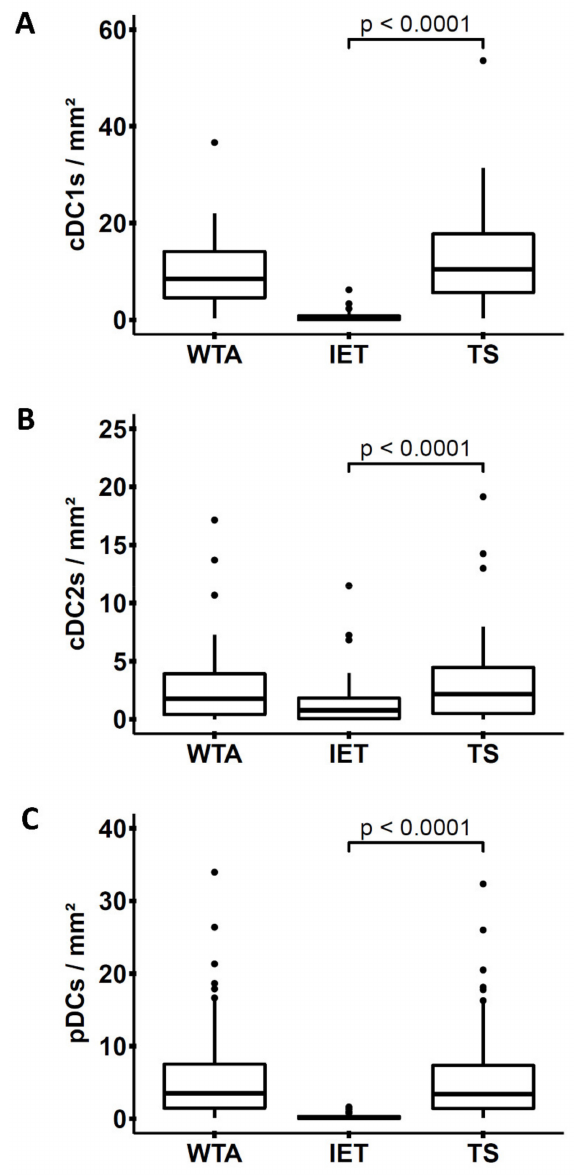
Figure 2. Frequency of pancreatic ductal adenocarcinoma (PDAC)-associated conventional dendritic cells (cDCs) and plasmacytoid dendritic cells (pDCs). Mean densities of PDAC-infiltrating ( A ) conventional DCs type 1 (cDC1s) ( n = 40), ( B ) type 2 (cDC2s) ( n = 40), and ( C ) plasmacytoid DCs (pDCs) ( n = 58) were calculated for the whole tumor area (WTA), intraepithelial tumor area (IET), and tumor stroma (TS). Significance was determined by using paired Wilcoxon test, and p ≤ 0.05 was considered